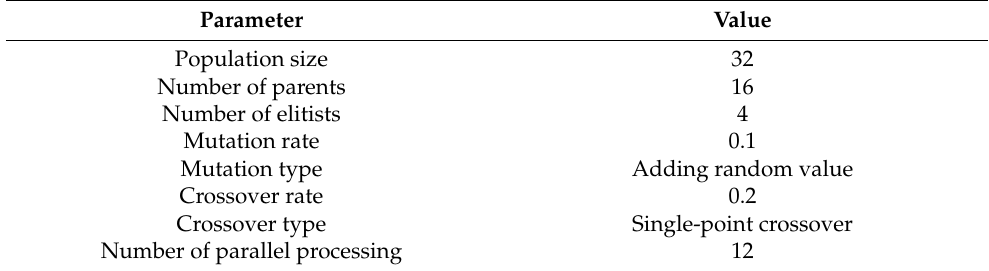
Table 1. The parameters for GA